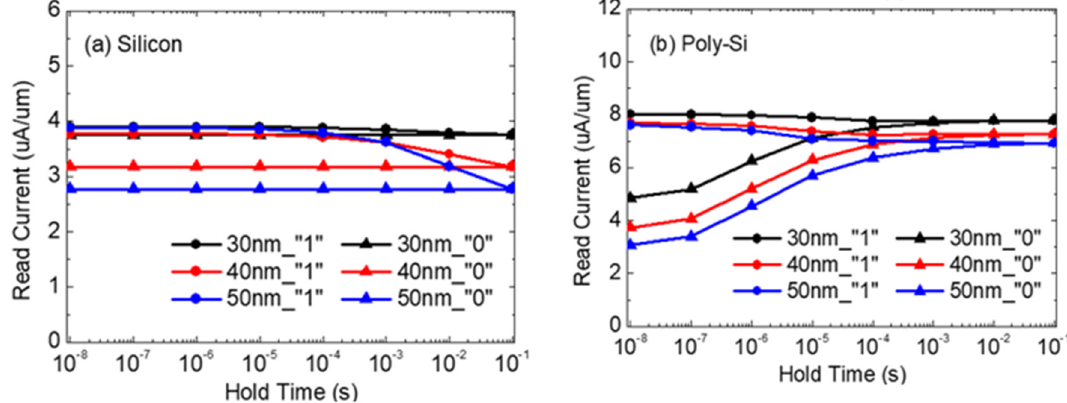
Figure 2. Transient characteristics of ( a ) silicon and ( b ) poly-Si 1T-DRAM according to T body / @T = 300 K.